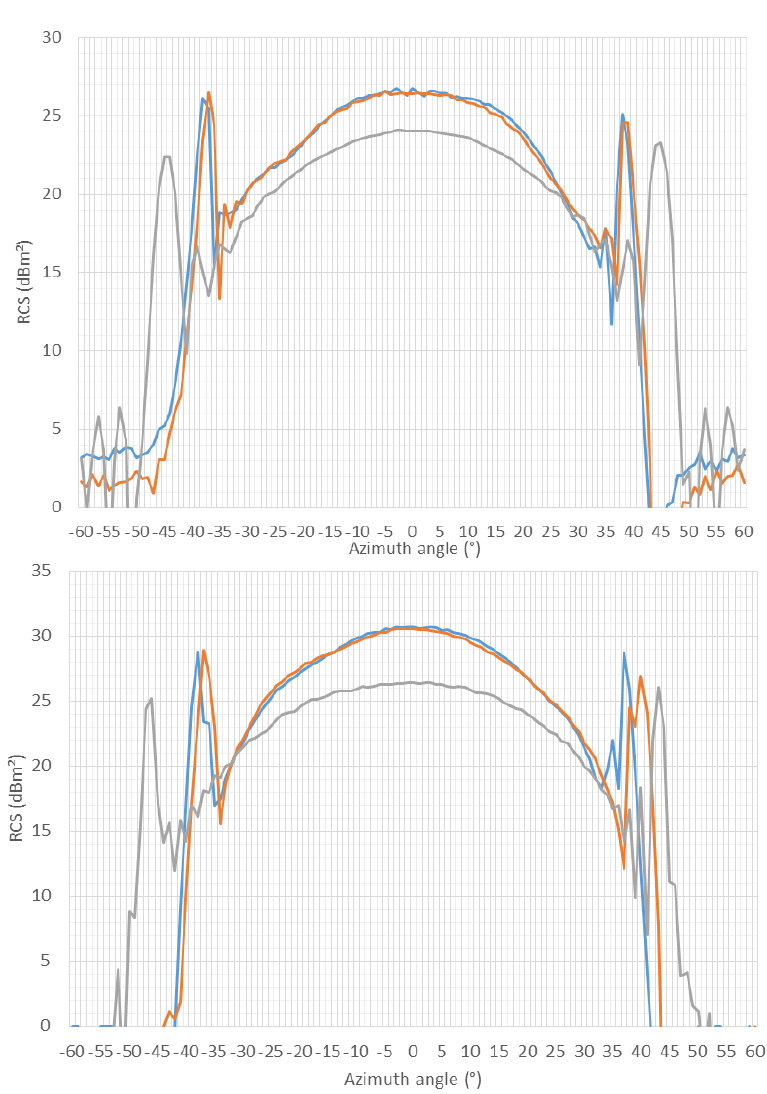
Figure 4. RCS measurements of CR1, CR2 and CR3 in C-band ( top ) and X-band ( bottom ). Blue: CR1, Orange: CR2, Grey: